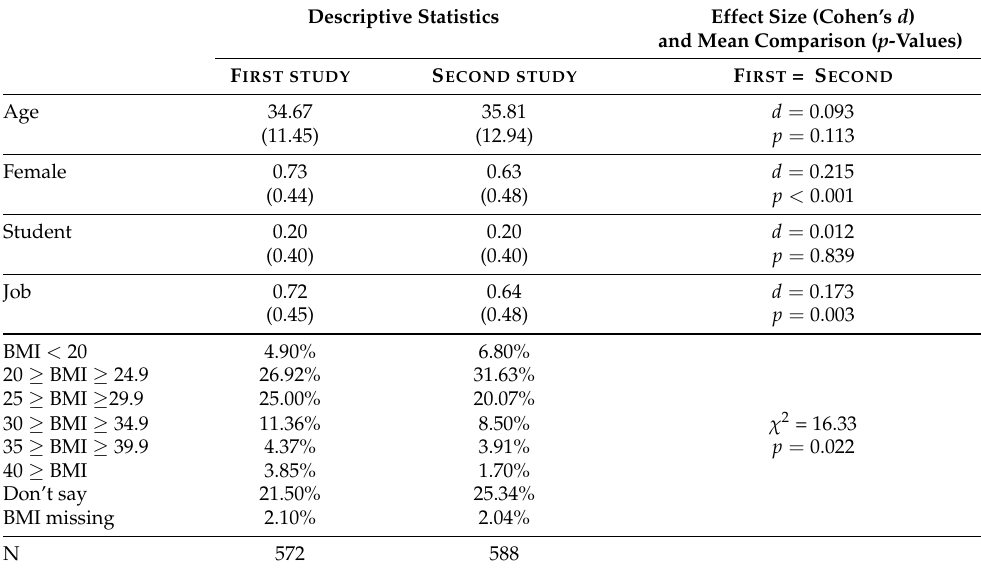
Table A6. Sample comparisons on